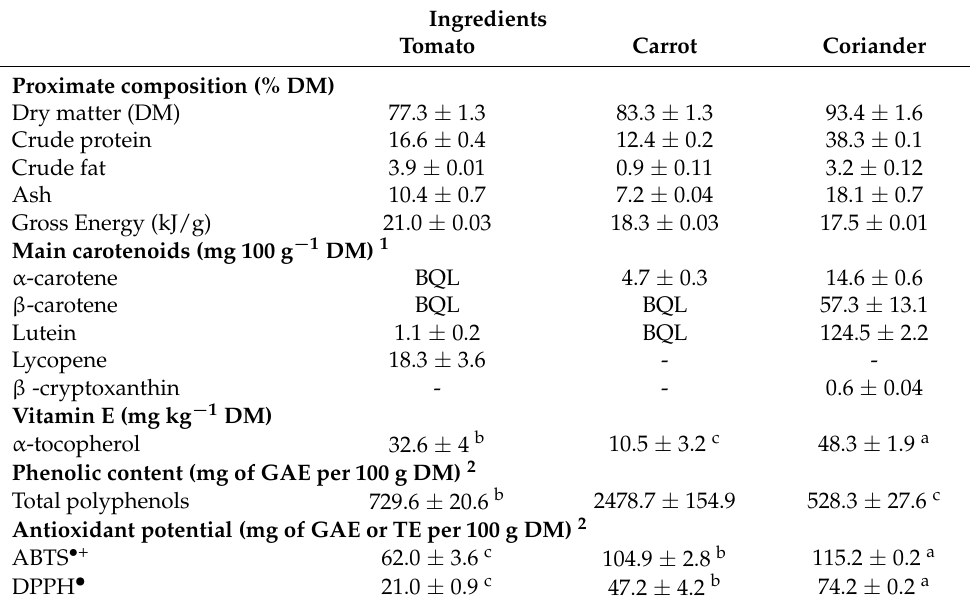
Table 1. Proximate composition, carotenoids, vitamin E and antioxidant potential of ingredients. Ingredients